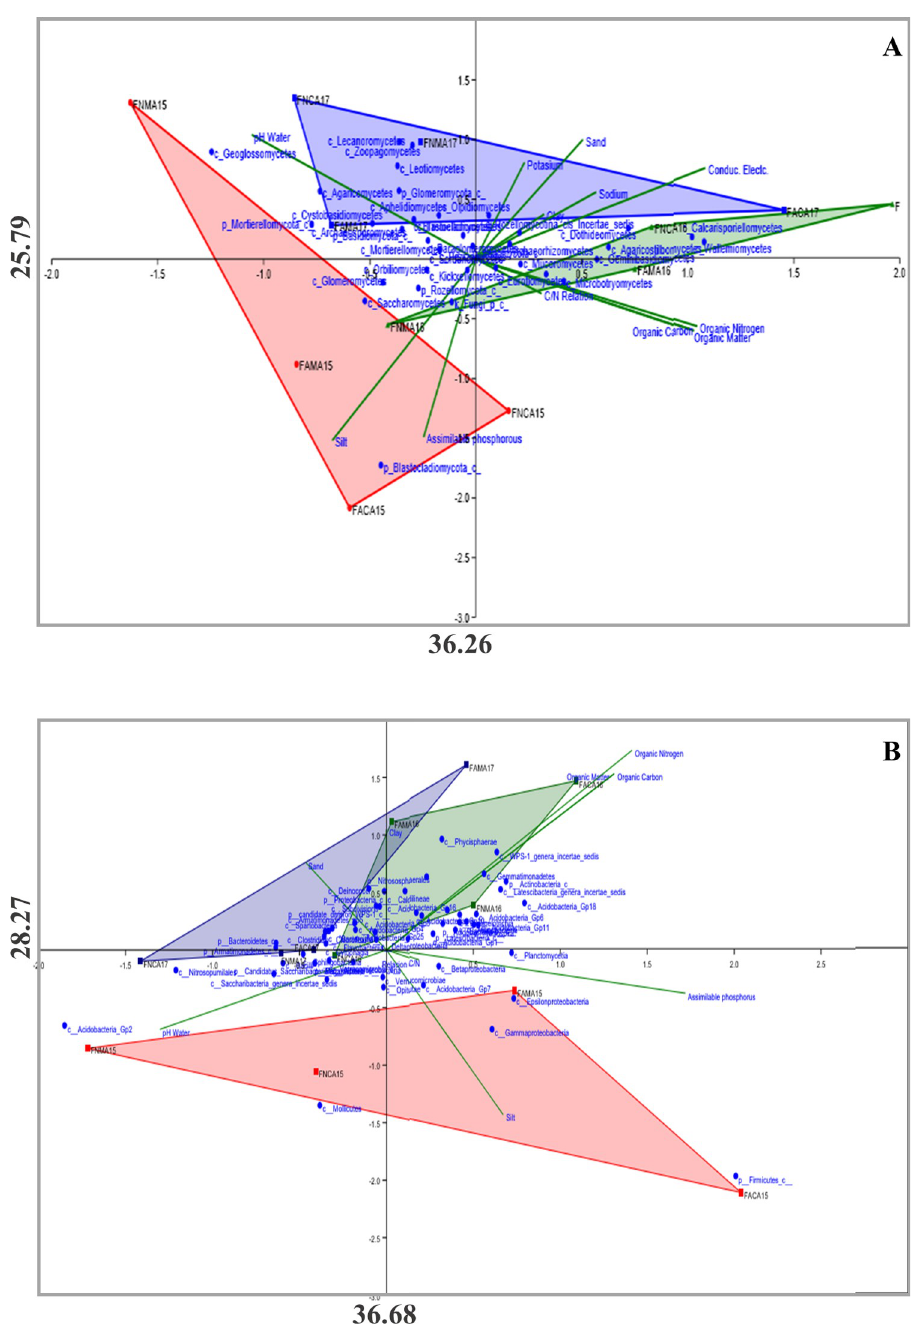
Fig 4. Canonical Correspondence Analysis (CCA) of fungal and bacterial communities. (A) Represents the CCA analysis of the main abundant fungal classes and (B) represents the CCA analysis of the main abundant bacterial classes classified. The 2015 samples are marked in red, the 2016 in green and the 2017 in